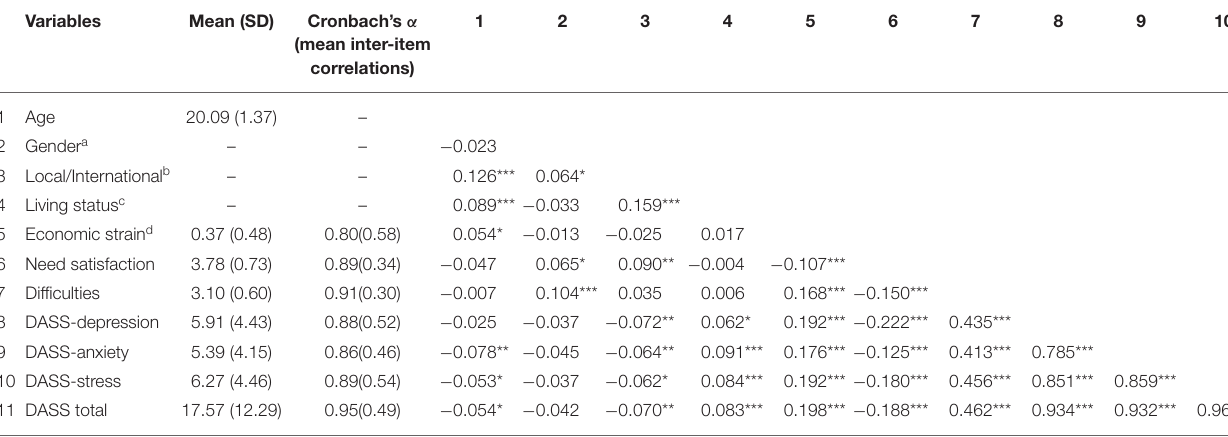
TABLE 1 | Statistics of mean, SD, reliability, and correlations. Variables